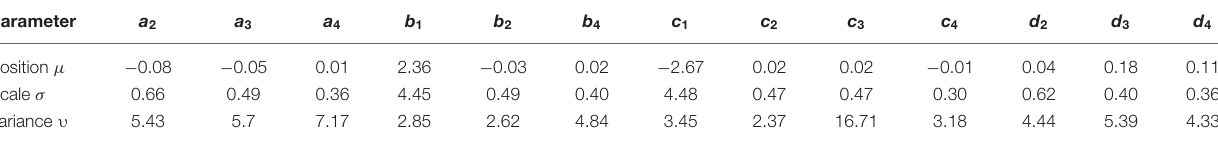
TABLE 2 | Calculation results of evaluation indices by modeling different orders of the Fourier method. Parameter Position